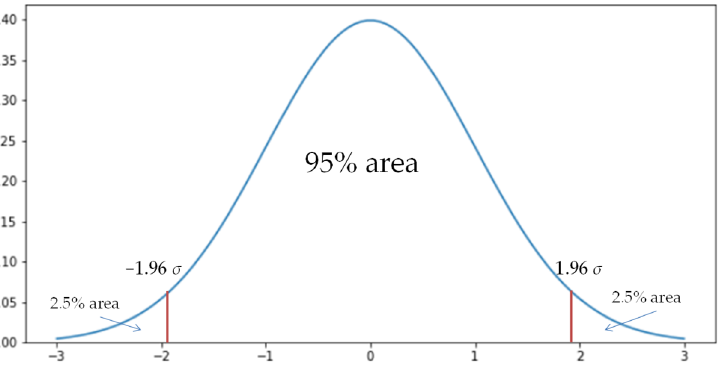
Figure 6 . Graph showing (cid:3399) 1.96 σ and 95% CI for the mean . Data source: Altman et al.